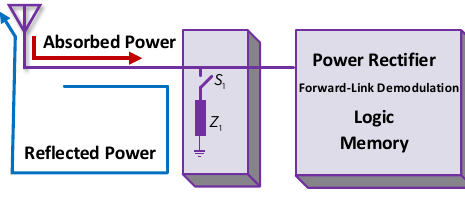
Figure 19. An amplitude shift keying (ASK) or phase shift keying (PSK) modulator for